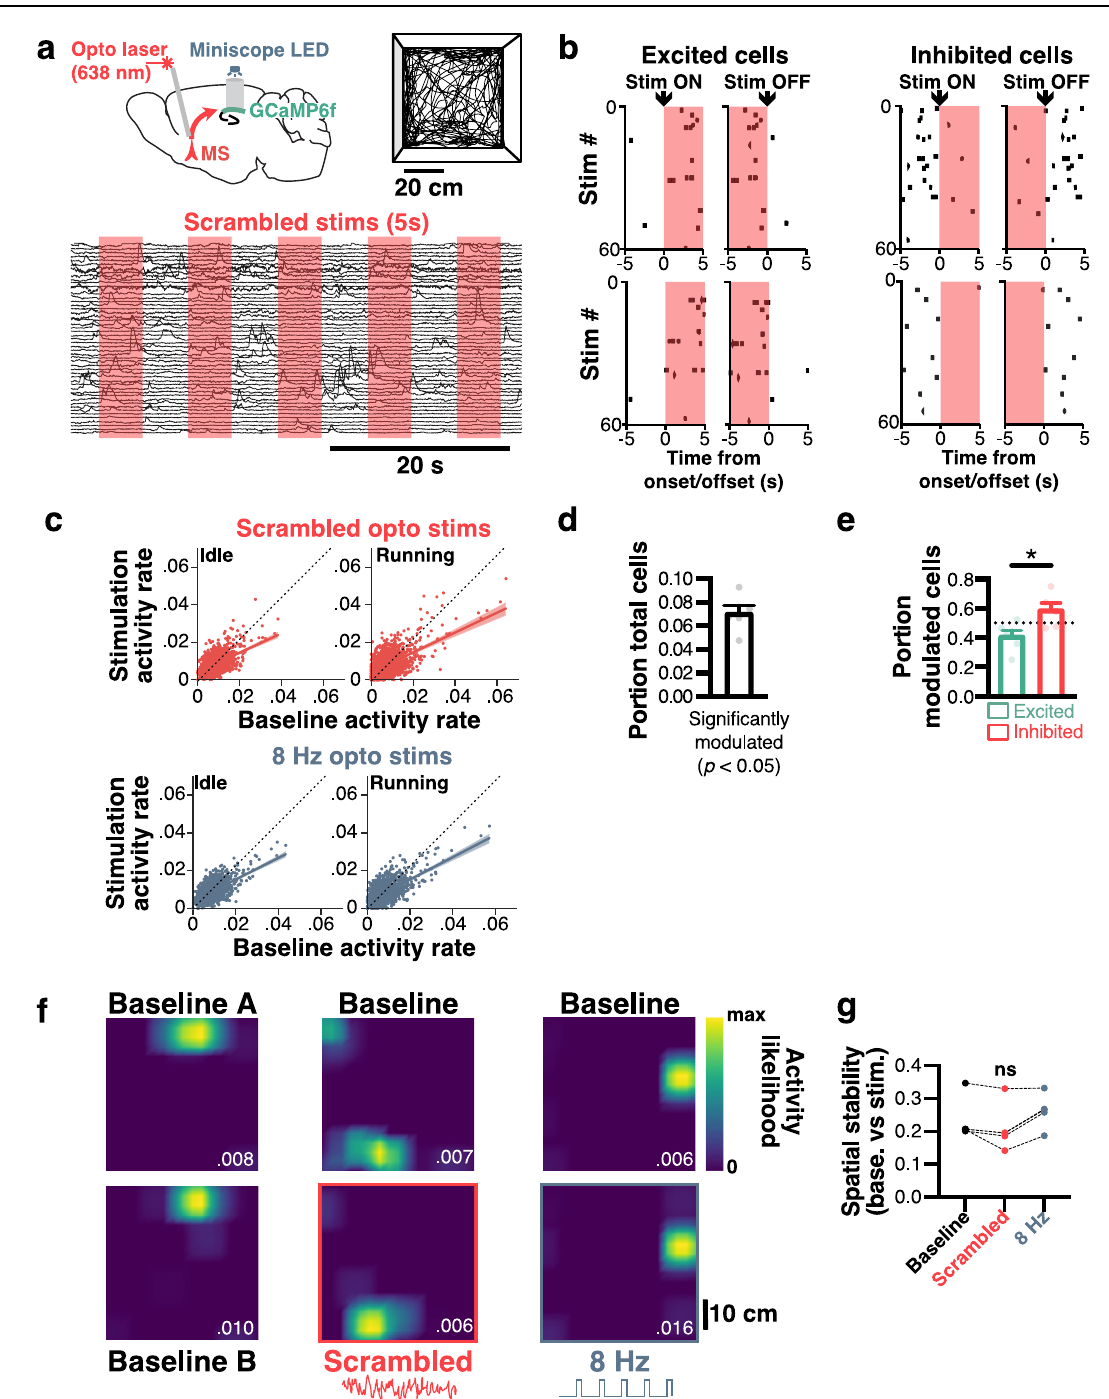
Fig. 4 | MSoptogenetic stimulationmodulatestheactivity ofa subpopulation of CA1 pyramidal cells. a Recording CA1 neurons during MS optogenetic stimu- lation (5s ON, 5s OFF) while simultaneously imaging CA1 neurons in mice freely exploring an open fi eld. b Peristimulus time raster plot of binarized activity for pairs of excited (left) or inhibited (right) neurons. c Scatter plot for all pooled neurons ( n =1849 cells, N =5 mice) of activity probability during baseline vs sti- mulation(red, top:scrambled;blue,bottom:8Hz),forbothidle(left)and running (right) periods. d Portion of total cells signi fi cantly modulated by stimulations ( N =5mice). e Portionofmodulatedcellsthatareexcited(green)orinhibited(red; two-tailed unpaired t -test, t 8 =2.511, p =0.0363, N =5 mice). f Spatially tuning of